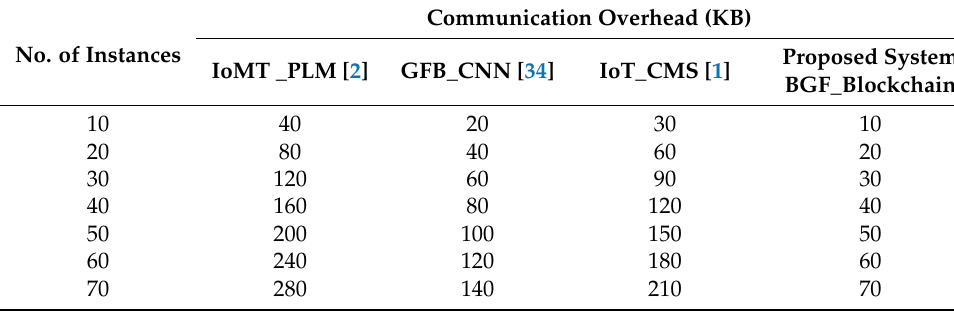
Table 3. Comparison of overhead with the existing